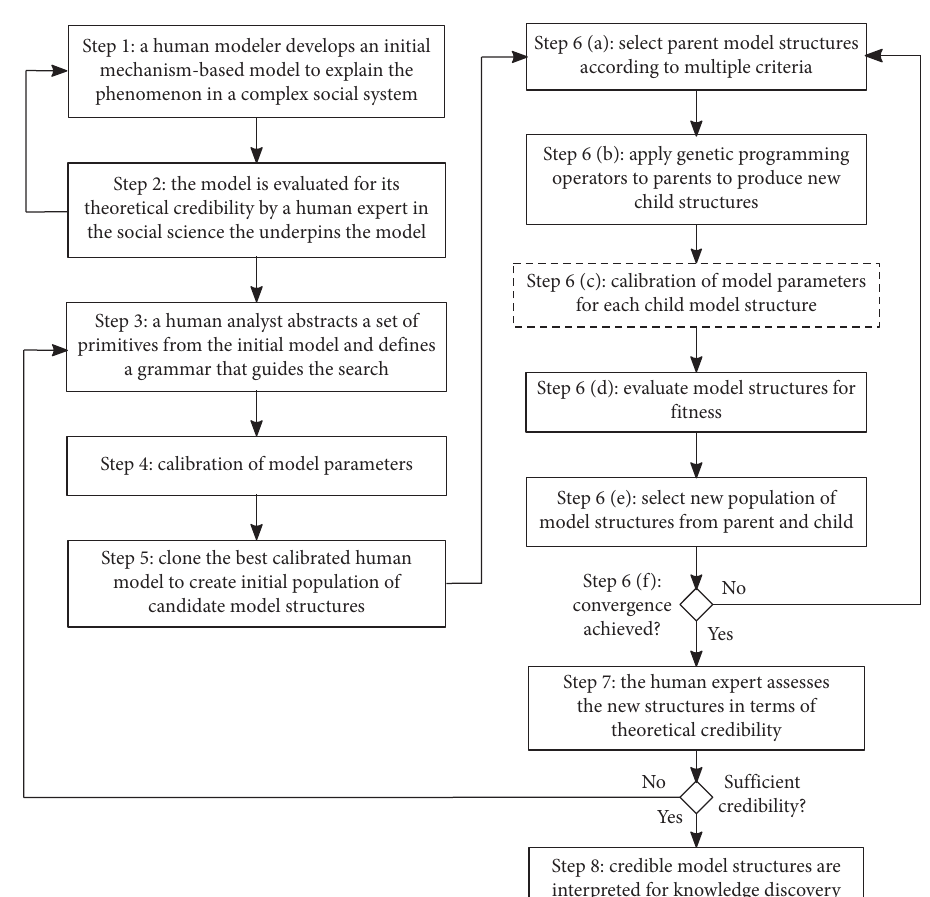
Figure 2: Model discovery framework. The dashed rectangle is the process that is not implemented in the present paper.